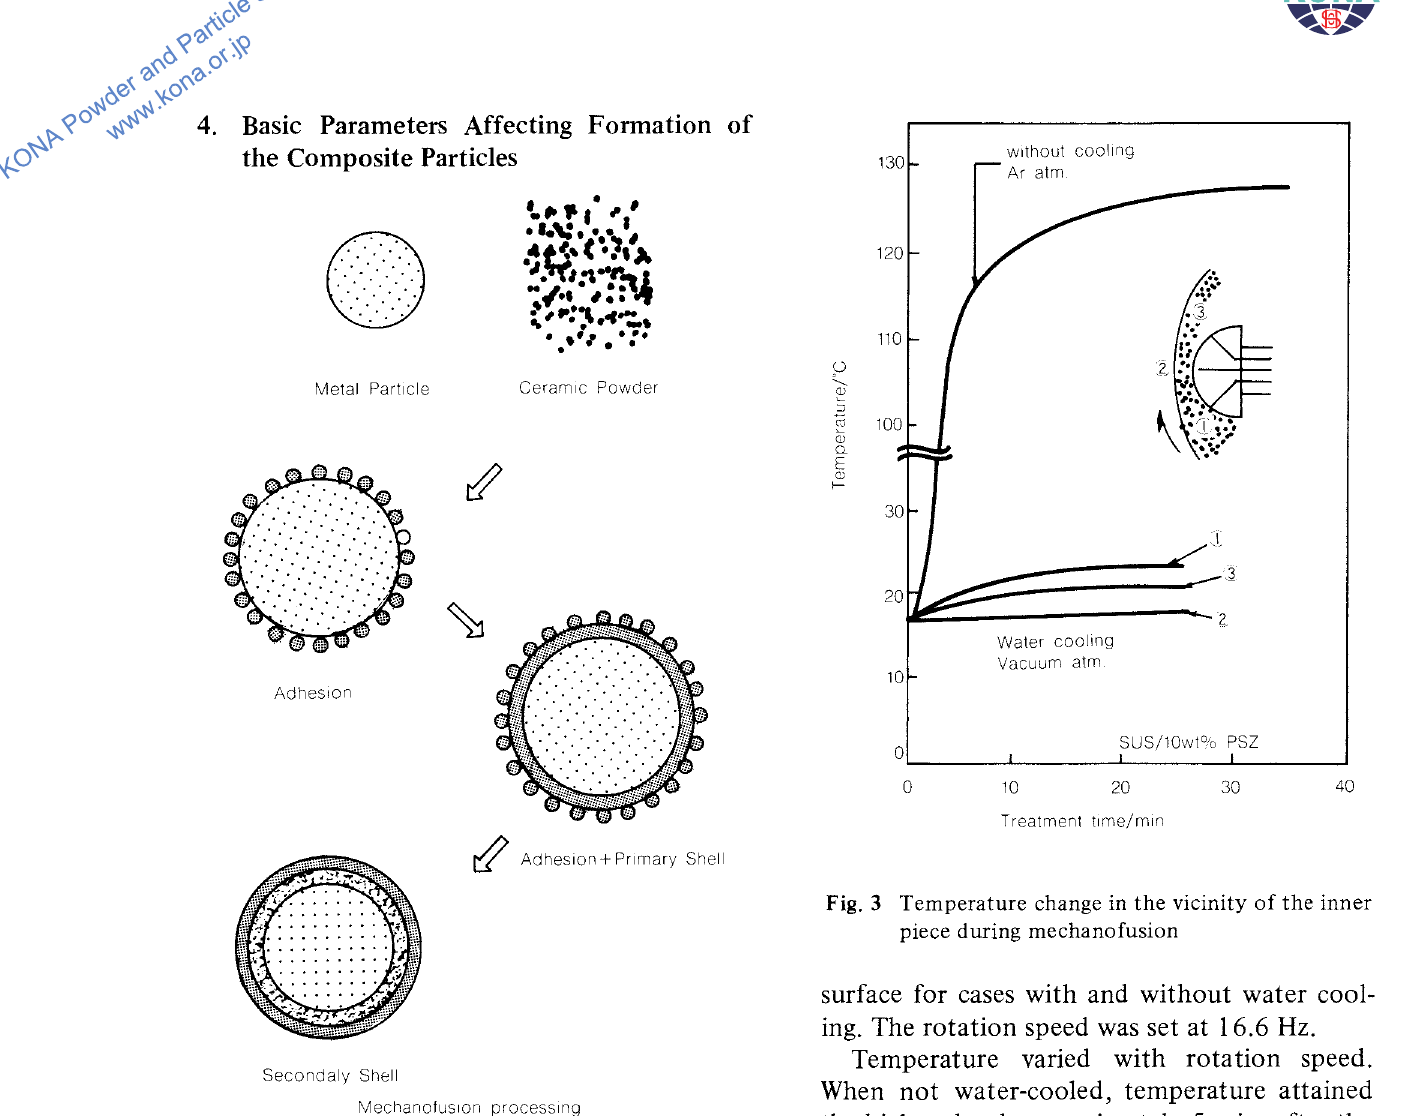
Fig. 3 Temperature change in the vicinity of the inner piece during mechanofusion surface for cases with and without water cool ing. The rotation speed was set at 16.6